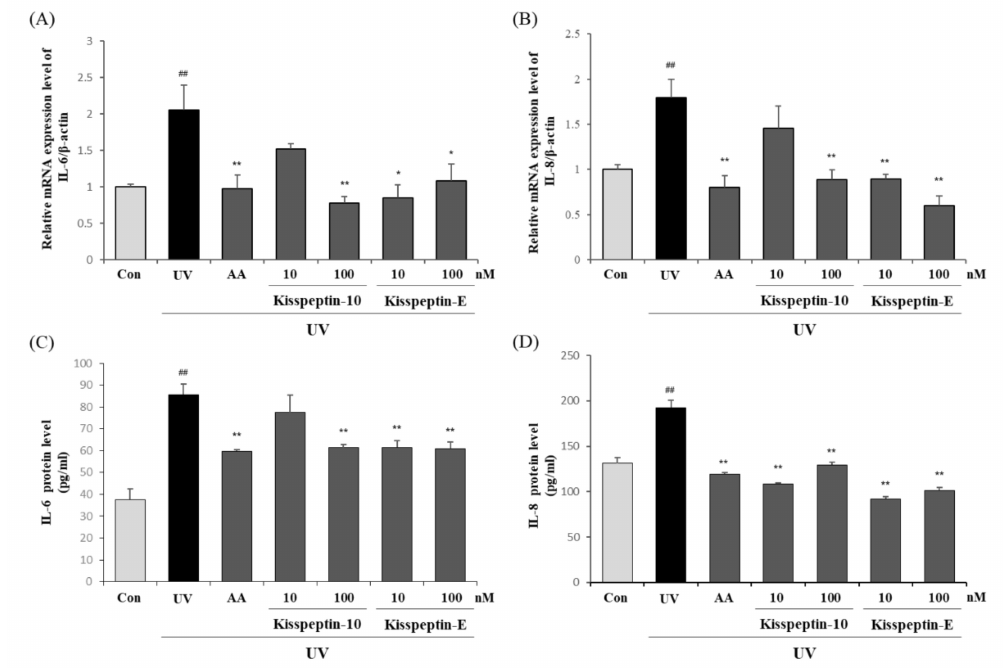
Figure 4. Kisspeptin-mimicking peptides decreased mRNA and protein expressions of IL-6 and IL-8 in UVB irradiated Hs68 fibroblasts. The Hs68 fibroblasts were treated with Kisspeptin-10 and Kisspeptin-E for 24 h after UVB irradiation. The mRNA expression ( A , B ) and protein secretion ( C , D ) of IL-6 and IL-8 were measured by RT-qPCR and ELISA. The means ± SEs are the average of three independent experiments. AA, Ascorbic acid; ## p < 0.01 indicates a significant di ff erence from the control. * p < 0.05 and ** p < 0.01 indicate a significant di ff erence from the UVB-induced